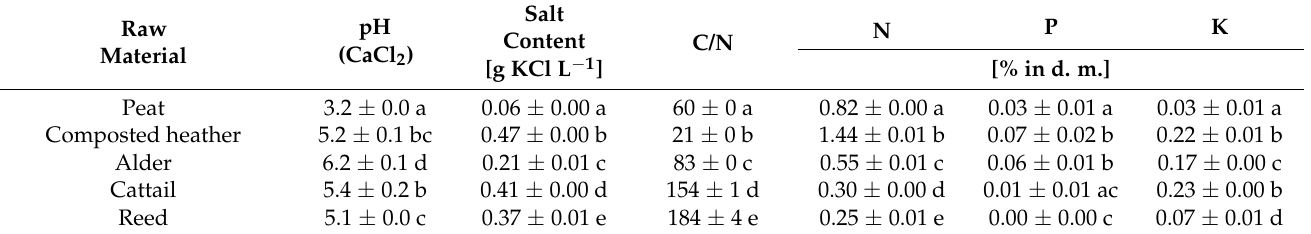
Table 2. Basic parameters of the investigated raw materials in stage 1. n = 3, variance analysis: Kruskal–Wallis (except P: ANOVA), post hoc test: pairwise t test, p < 0.05. Different letters indicate significant differences among raw materials. d.m.: dry